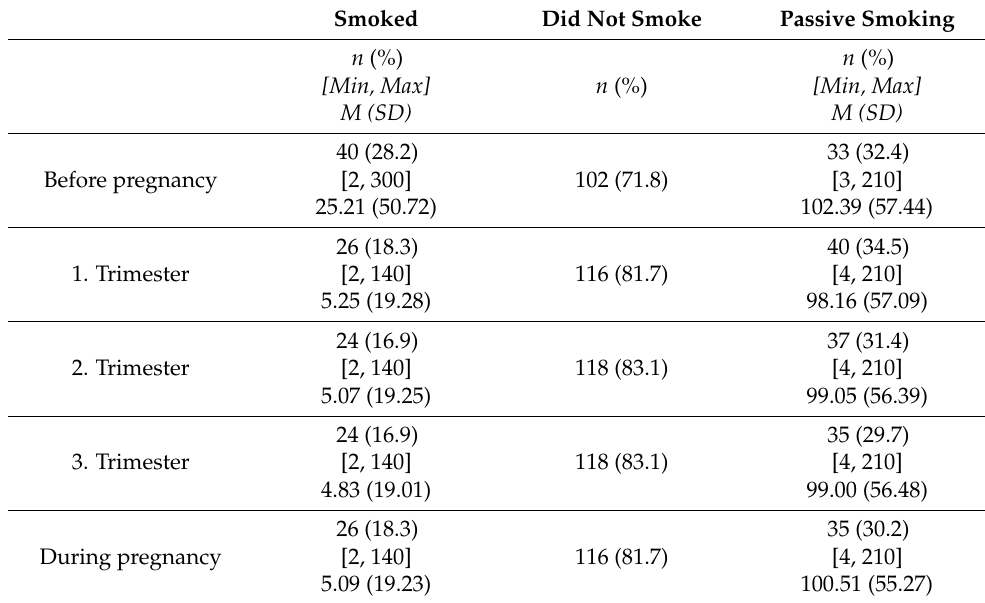
Table 2. Detailed information on maternal smoking